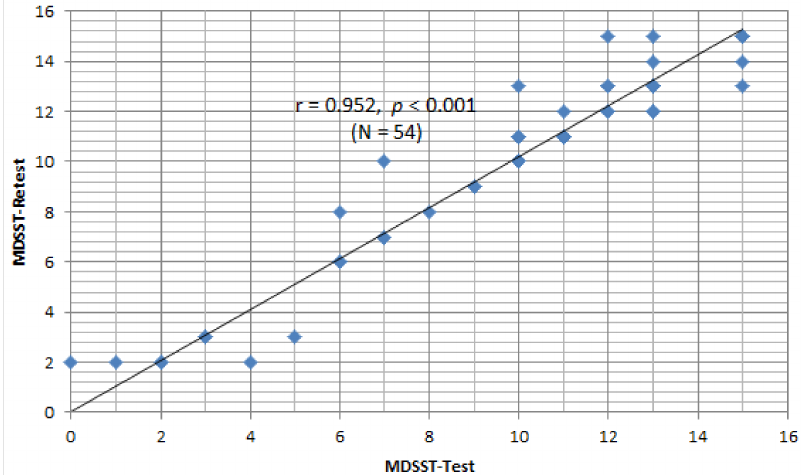
Figure 1. Test–retest reliability of web